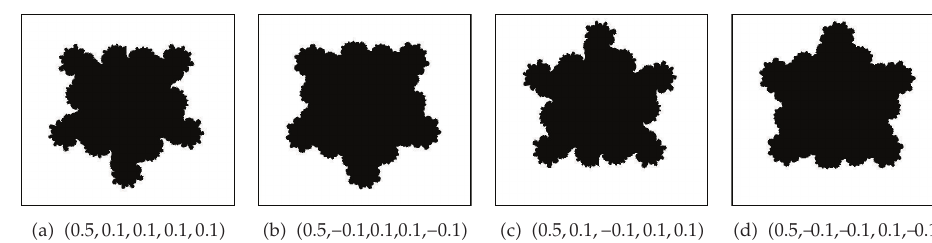
Figure 25: The generalized J sets perturbed by the composing noise, here Figures (cid:3) a (cid:4) and (cid:3) b (cid:4) are the graphs when α (cid:6) 5.5, θ ∈ (cid:7) − π/ 2 , 3 π/ 2 (cid:4) with c (cid:6) 0 . 5 (cid:5) 0 . 5 i ; Figures (cid:3) c (cid:4) and (cid:3) d (cid:4) are the graphs when α (cid:6) 5.5, θ ∈ (cid:7) − 3 π/ 2 ,π/ 2 (cid:4) with c (cid:6) 0 . 5 − 0 . 5 i .